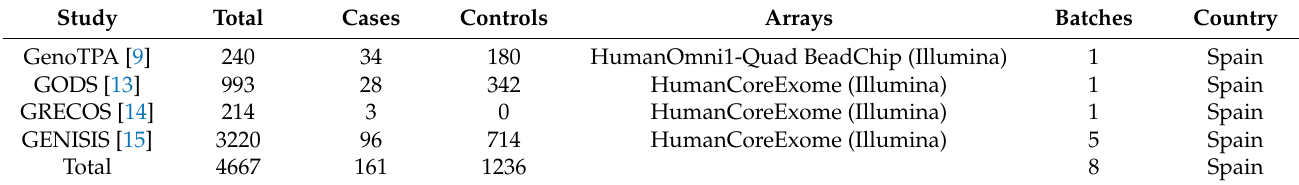
GenoTPA: Genetic Study in Ischemic Stroke Patients treated with recombinant tissue plasminogen activator (r-tPA); GODS: Genetic contribution to Functional Outcome and Disability after Stroke; GRECOS: Genotyping Recurrence Risk of Stroke study; GENISIS: Genetics of Early Neurological Instability After Ischemic